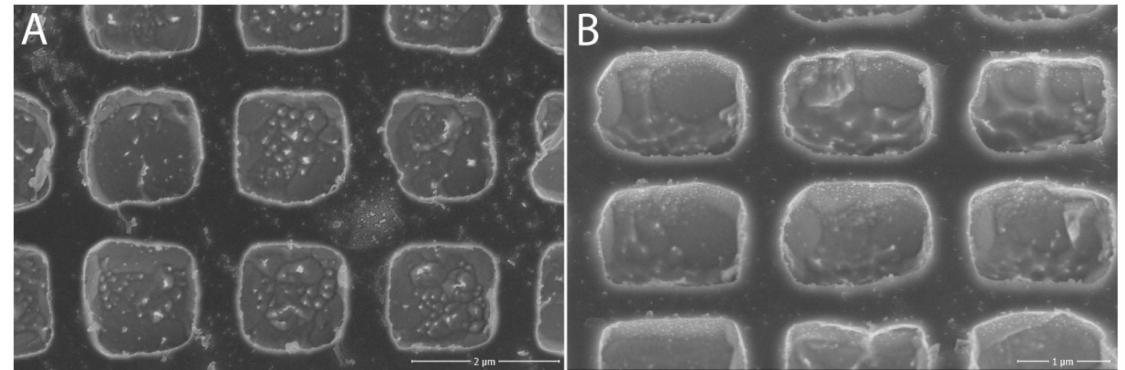
Figure 5. Lattice A2 under SEM microscope: ( A ) view of the structure; ( B ) at 45 ◦ inclination. Adapted from [15] with kind permission of Brno University of